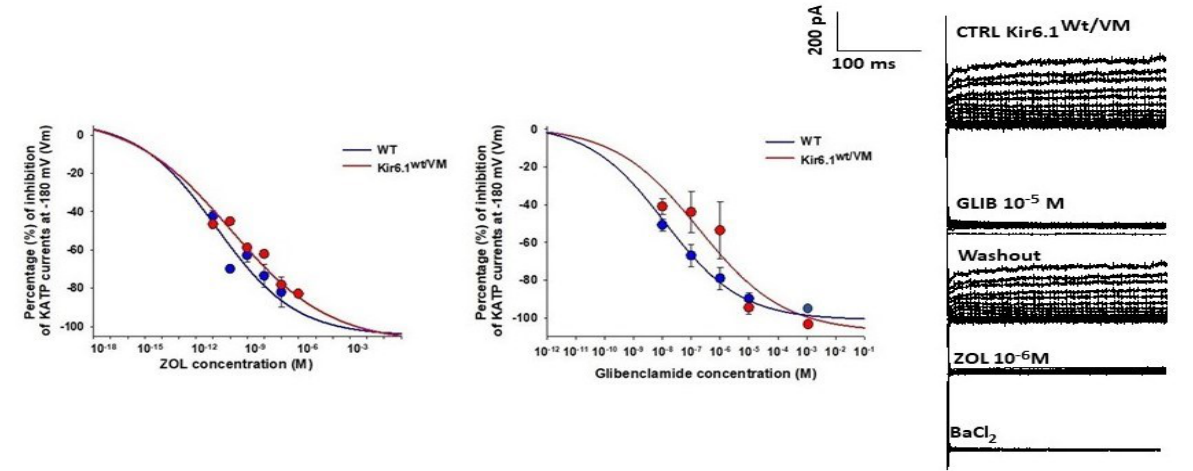
Figure 3. Concentration–response relationships of zoledronic acid (ZOL) and glibenclamide (GLIB) concentrations vs. KATP current percentage inhibitions in bone calvaria cells from heterozygous Kir6.1 wt/V56M CS mice. The experiments were performed in a whole-cell configuration in the physio- logical conditions of the membrane patches during voltage steps going from 180 mV to +100 mV (Vm). The drug solution was applied on the extracellular side of the patches using a fast perfusion system. The cells were equilibrated for 10 s with the drug solution before recordings. The concen- tration – response curves of glibenclamide to reduce the KATP channel currents of Kir6.1 wt/V56M oste- oblasts were significantly shifted to the right on the log concentration axis concerning the WT/WT bone cells. Zoledronic acid potently inhibited the KATP currents in the Kir6.1 wt/V56M osteoblasts. Rep- resentative traces of KATP currents in osteoblasts related to the effects of glibenclamide and zoledronic acid on whole-cell KATP currents in osteoblasts are reported. The current is identified by the glibenclamide response applied to the patches. A washing period of 10 s is applied before recording. Each point of the concentration – response curves was obtained on 16 – 23 patches. Table 1. Fitting parameters of the concentrations-response relationships in different Cantú syn- drome (CS) mice genotypes and cells.